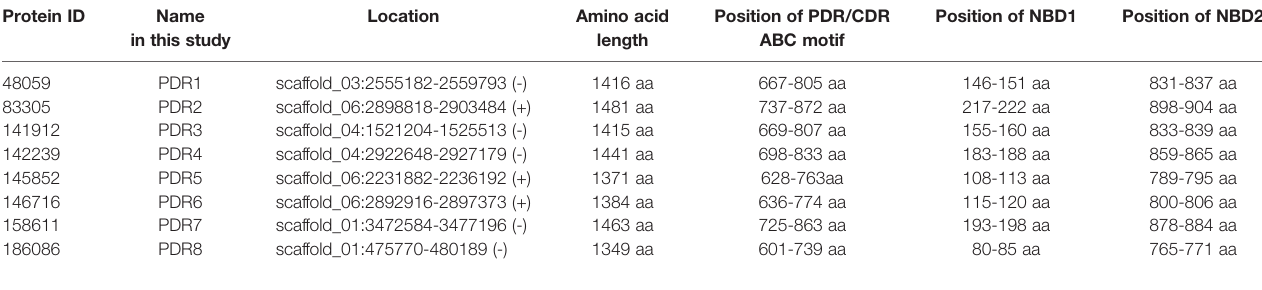
TABLE 1 | The eight identi fi ed pleiotropic drug resistance protein genes and their location in the genome of M. circinelloides . Protein